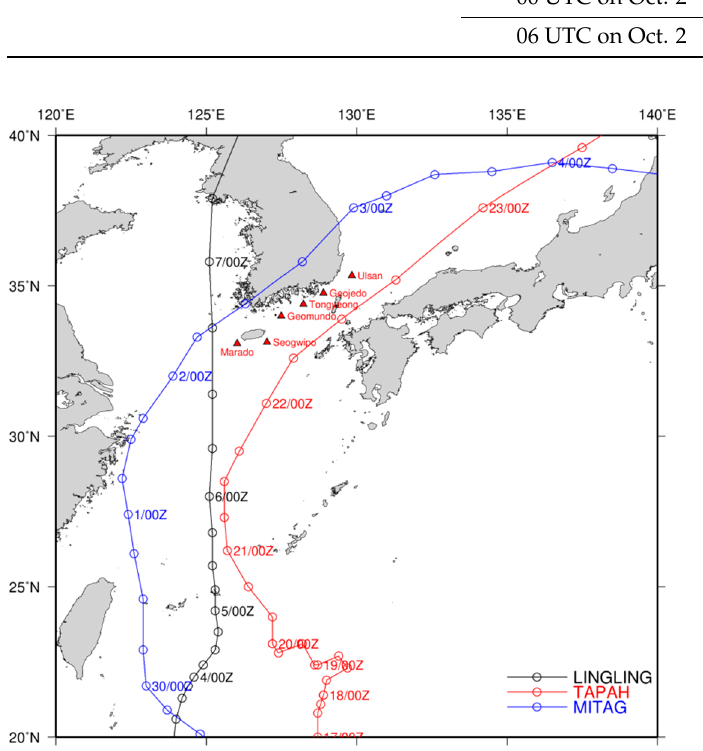
Figure 2. Typhoon tracks of Lingling, Tapah, and Mitag (lines with open circles) and the locations of wave height observations (red triangles). Here, time information of tracks is formatted as date/hour in UTC.